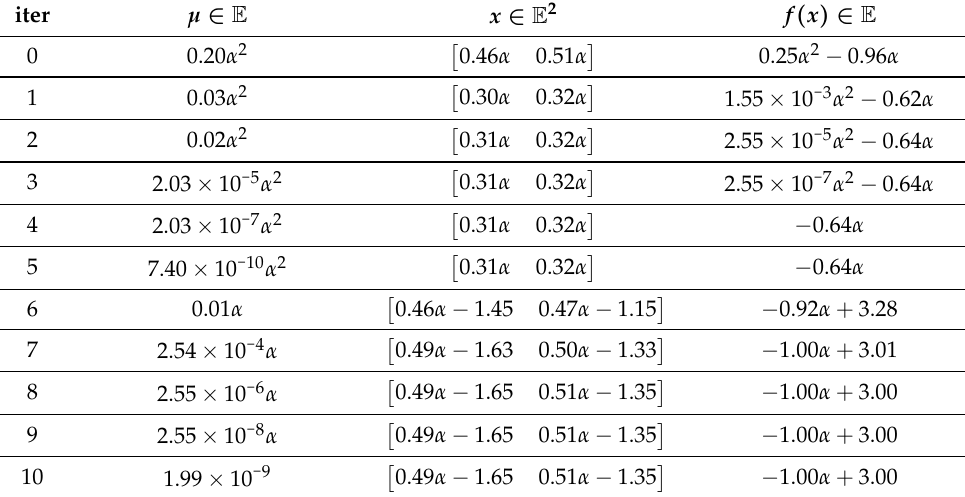
Table 2. Iterations of the NA-IPM solving the problem in